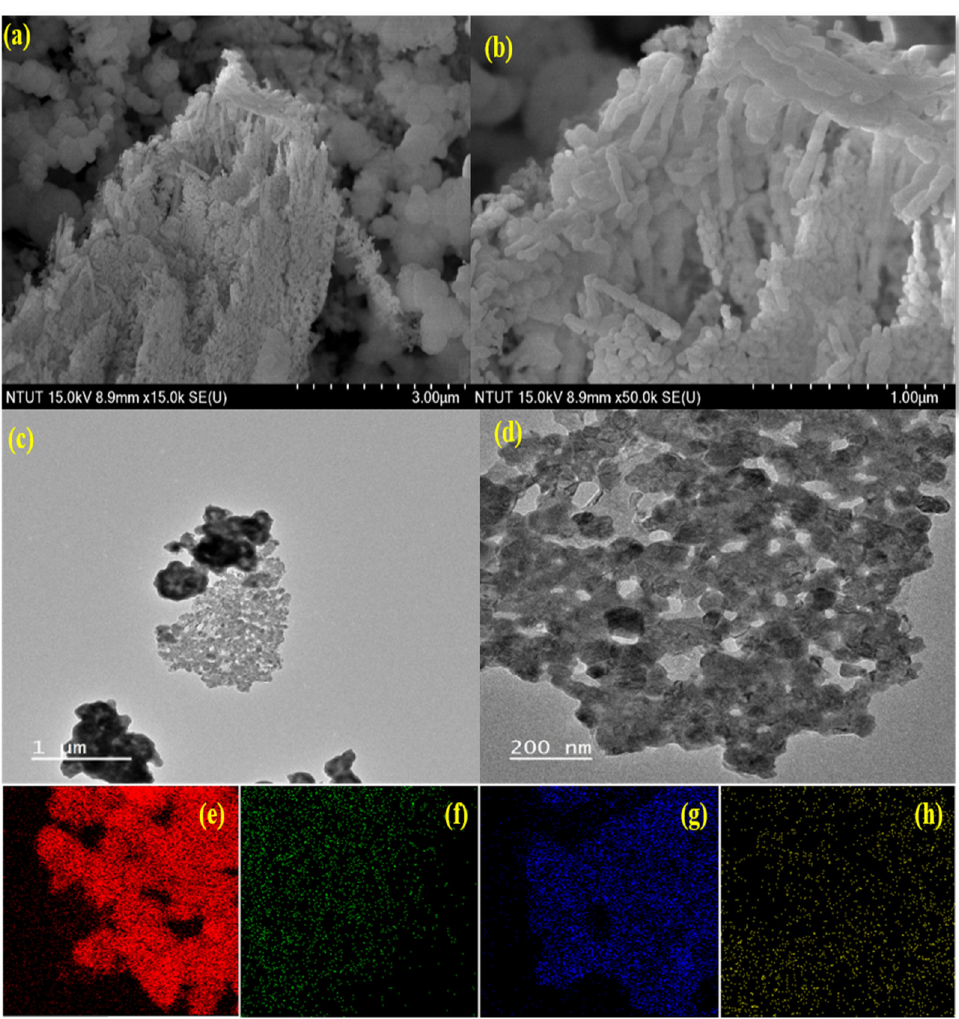
Figure 3. ( a , b ) Surface morphology of synthesized Cu/La/CeO 2 /GO nanocomposites. ( c , d ) TEM im- ages for Cu/La/CeO 2 /GO nanocomposites, and elemental mapping for Cu/La/CeO 2 /GO nanocom- posites: ( e ) Ce, ( f ) Cu, ( g ) La, and ( h )